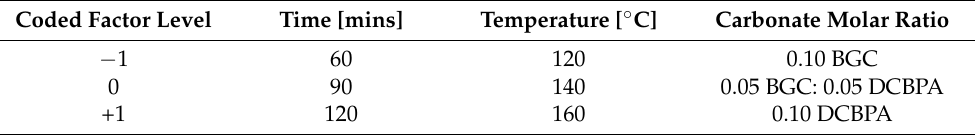
Table 2. Applied levels of the factors. Coded Factor Level